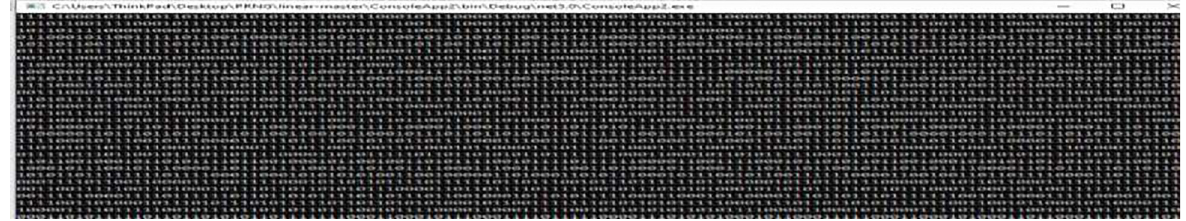
Fig 12. Corresponding Ciphertext.